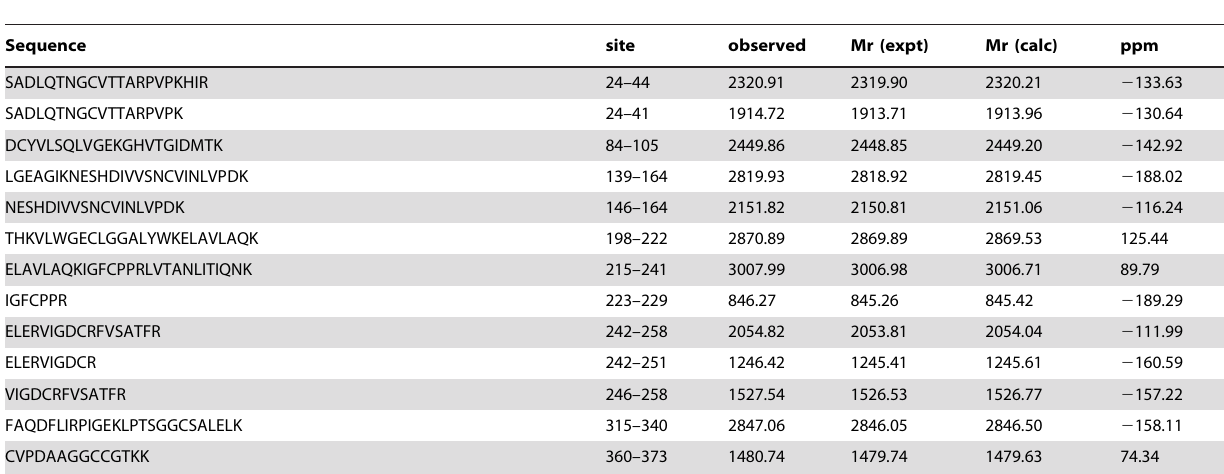
Table 2. Sequences for the peptide fragments of reduced hAS3MT analyzed by MALDI-TOF-MS.